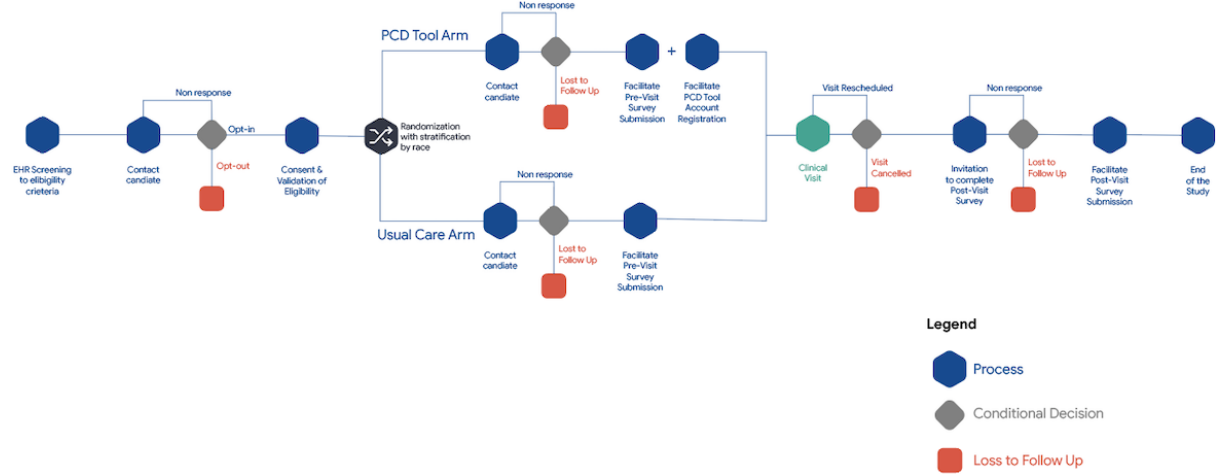
Figure 1. Randomized controlled trial study